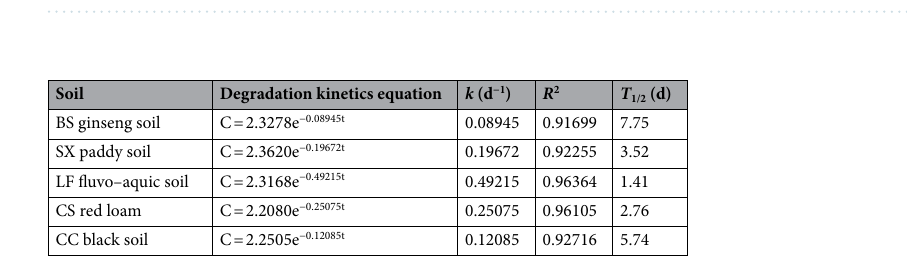
Table 8. Degradation kinetics parameters of propaquizafop in different